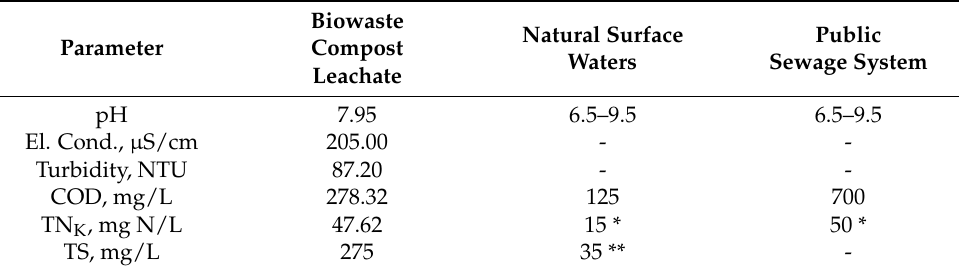
Table 3. Biowaste compost leachate characterization and the admissible values according to Croatian